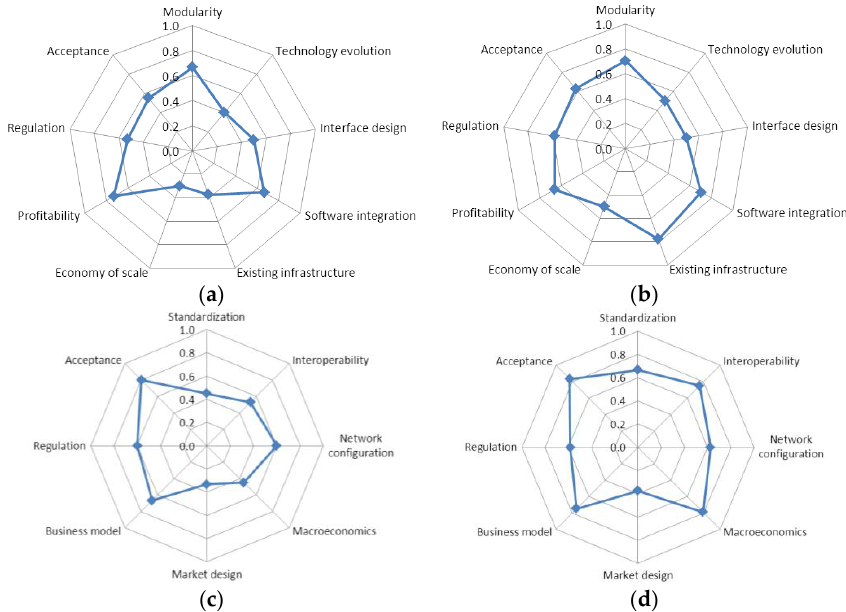
Figure 3. Comparison of scores: ( a ) scalability and ( b ) replicability factors of distribution projects, and ( c ) scalability and ( d ) replicability factors of transmission projects.